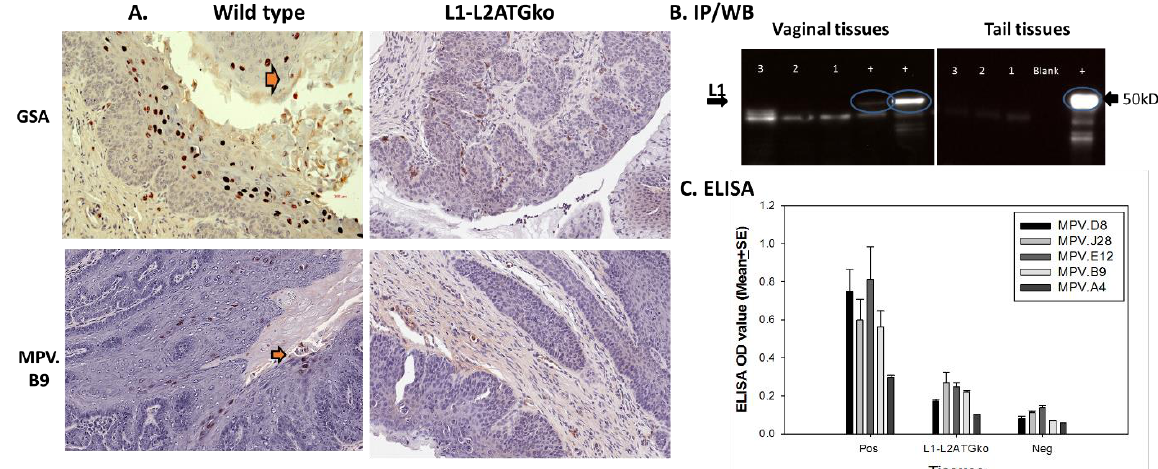
Figure 8. No L1 protein was detected in L1-L2ATGko infected tissues by IHC, ELISA, and IP/Western . Both wild-type and L1 – L2 mutant infected tissues were examined for viral L1 using GSA and MPV.B9 antibody. No positive signals were detected in L1-L2ATGko mutant-induced tissues ( A , right panel), while positive signals could be detected in wild-type infected tissues (left panel, arrows). No L1 positive signals were detected in L1-L2ATGko mutant-infected vaginal tissues by direct Western blot (left, lanes 1 – 3 from three animals, two wild-type lesions as positive controls “+” ). No L1 was detected in L1-L2ATGko tail tissues (right, lanes 1 – 3 from three animals, one wild-type tail lesion as positive control “+”) in an IP/Western immunoprecipitation using MPV.A4 to pull down L1 and probing the blot with MPV.B9 ( B ). Wild-type and L1-L2ATGko mutant-infected tissues were also tested for L1 by ELISA ( C ) using a panel of in-house monoclonal antibodies including MPV.B9 and MPV.A4 that were raised against the mouse papillomavirus major capsid protein L1. No significantly difference was found between the L1-L2ATGko mutant and the negative group ( p > 0.05, Mann – Whitney rank-sum test).